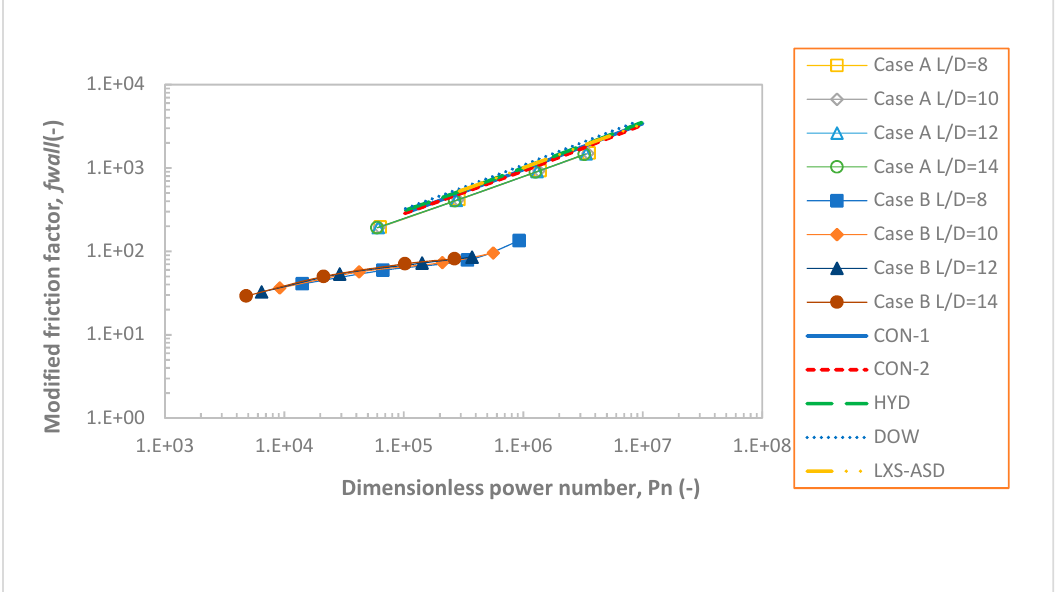
Figure 9. Comparison with the result of Haaksman et al. [9] in the commercial spacer simulation for the modified friction factor as a function of the dimensionless power number.